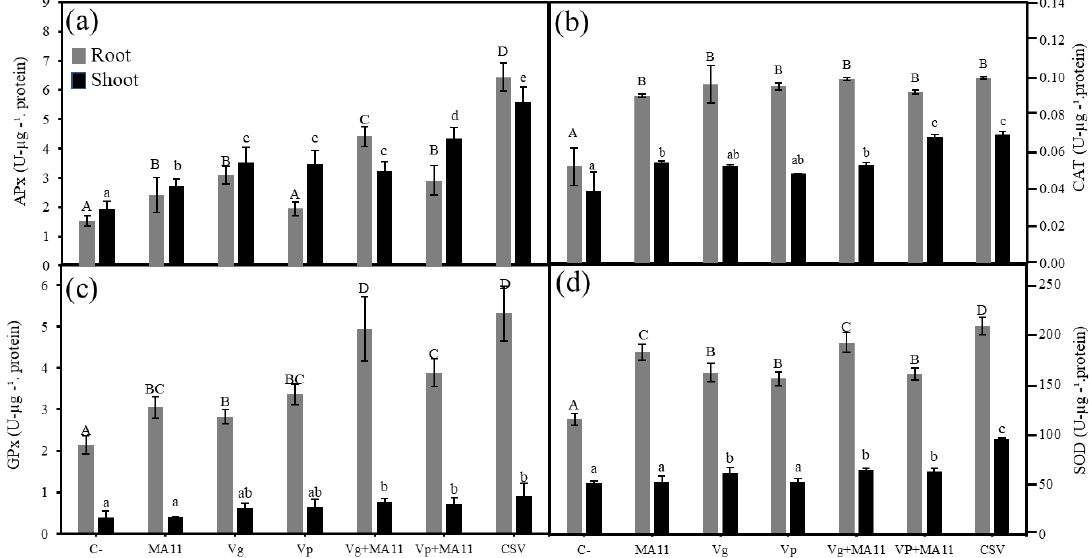
Figure 6. Antioxidant enzymes levels. ( a ) Ascorbate peroxidase, ( b ) catalase, ( c ) guaiacol peroxidase, and ( d ) superoxide dismutase activities in the leaves and roots of M. sativa after 60 days under greenhouse conditions with a nutrient-poor soil as a substrate. Values are means ± S.D. ( n = 16). Different letters indicate means that are significantly different from each other (one-way ANOVA; LSD test p < 0.0001). C – : non inoculation; MA11: inoculation with E. medicae MA11; Vg: inoculation with V. gossypii JM-310 T ; Vp: inoculation with V. paradoxus S110 T ; Vg + MA11: co-inoculation with V. gossypii JM-310 T and E. medicae MA11; Vp + MA11: co-inoculation with V. paradoxus S110 T and E. medicae MA11; CSV: inoculation with V. gossypii JM-310 T , V. paradoxus S110 T , and E. medicae MA11.